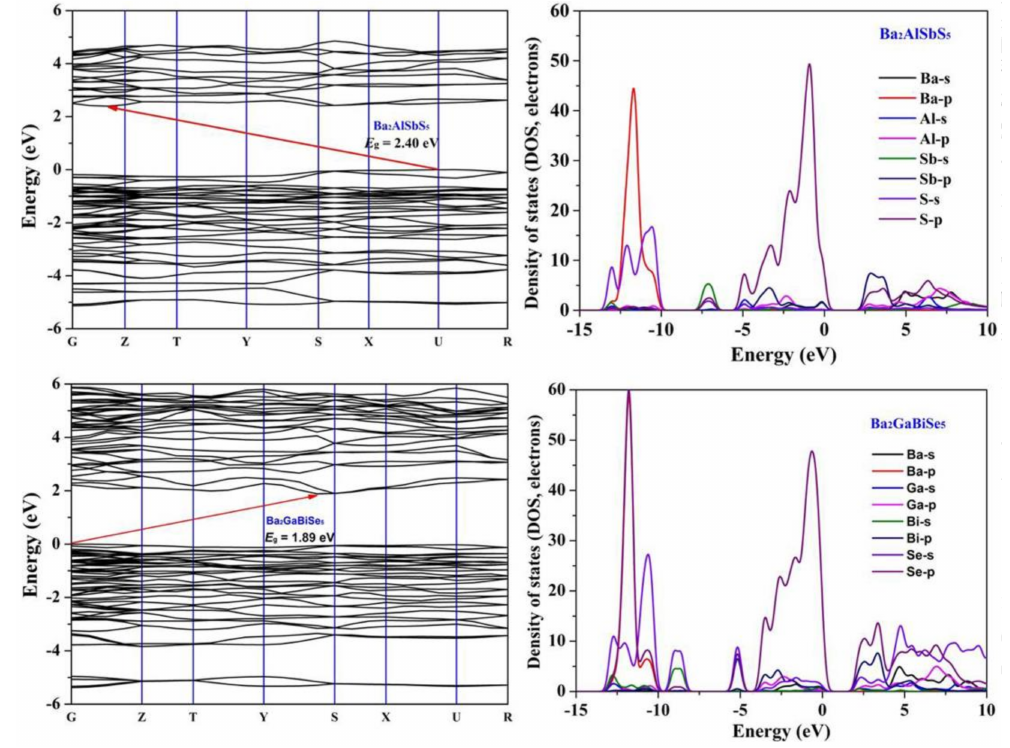
Figure 7. Band structures and PDOS diagrams of title